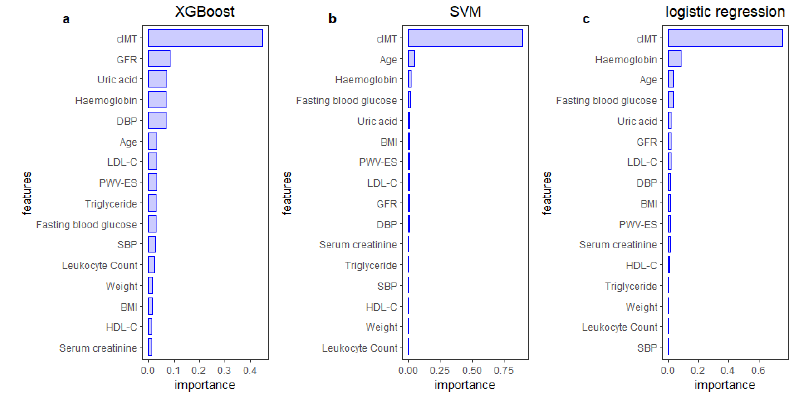
Figure 2. Feature importance analysis chart through (a) XGBooost, (b) SVM and (c) logistic regression.